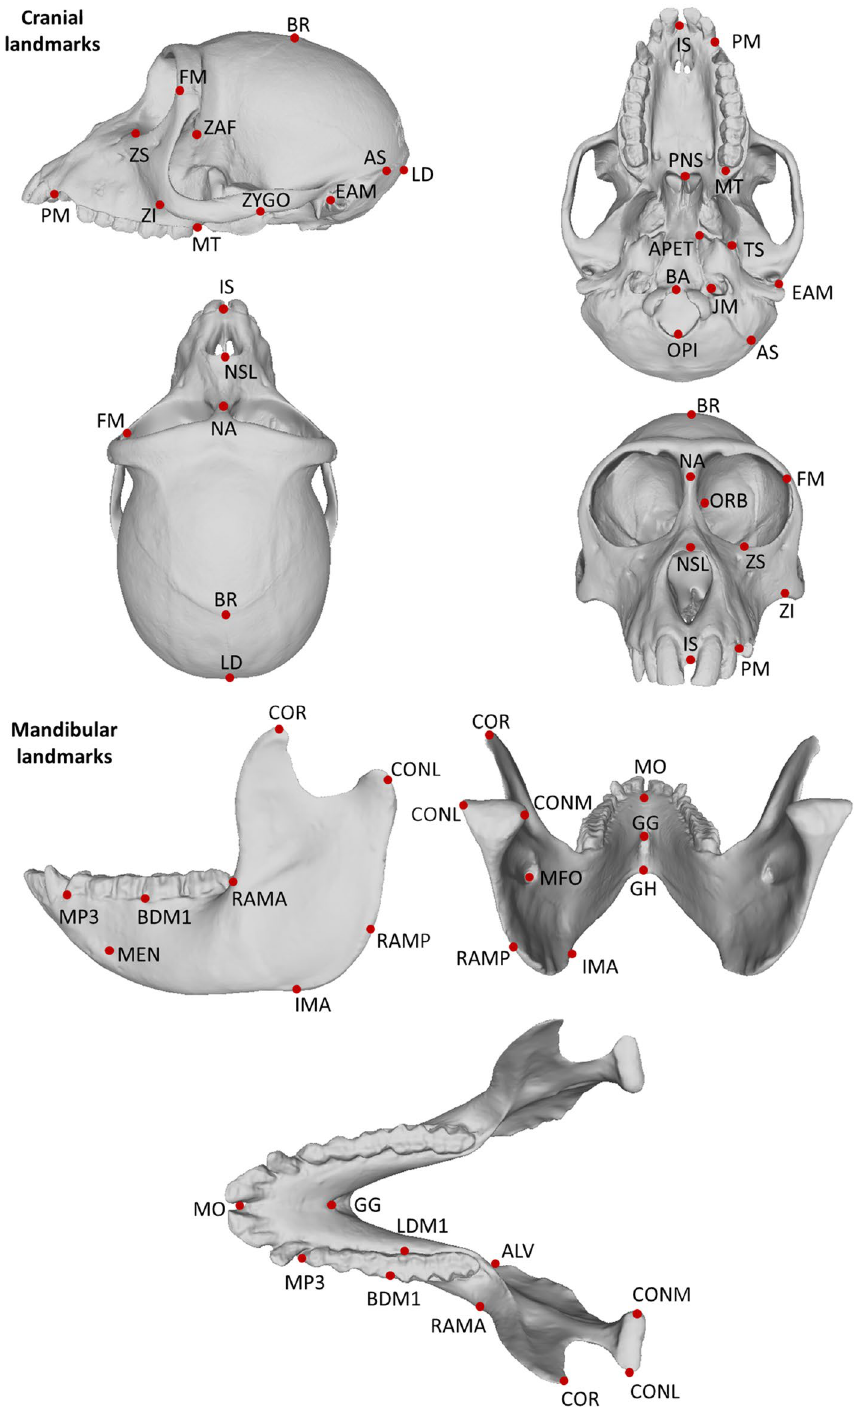
Figure 3. Landmarks recorded on Cercopithecidae crania and mandibles. Landmark descriptions and definitions of abbreviations given in Table 3. Scan images taken from scan of a Macaca mulatta individual (Specimen number: IMNH r389) downloaded from www. Morph osour ce. org, Duke University. Idaho Museum of Natural History provided access to these data. The collection of which was funded by Rick Carron